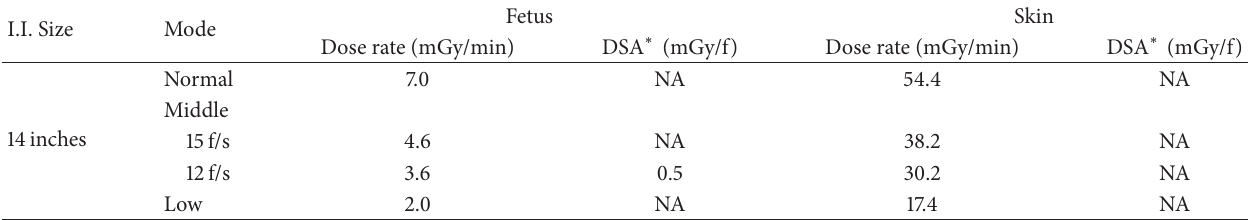
Table 1: Simulated results of radiation exposure with the Infinix Active DSA system in the angiography suite. I.I. Size